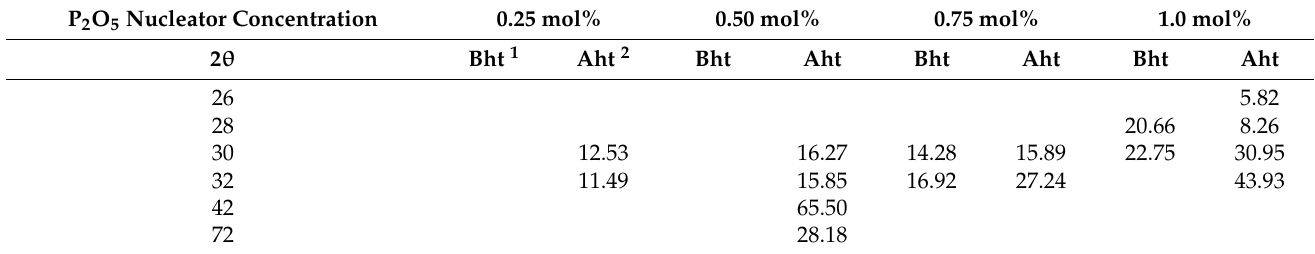
Table 1. XRD table crystallite size depends on theta angle, nucleator concentration, and heat treatment process (all crystallite sizes in nm).